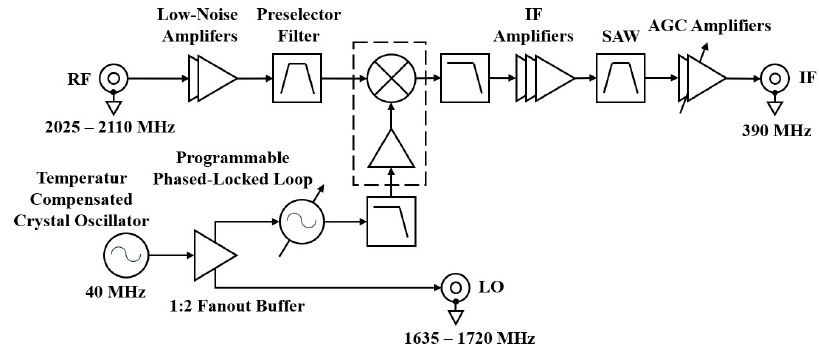
Figure 1. Radio frequency (RF) receiver block diagram.